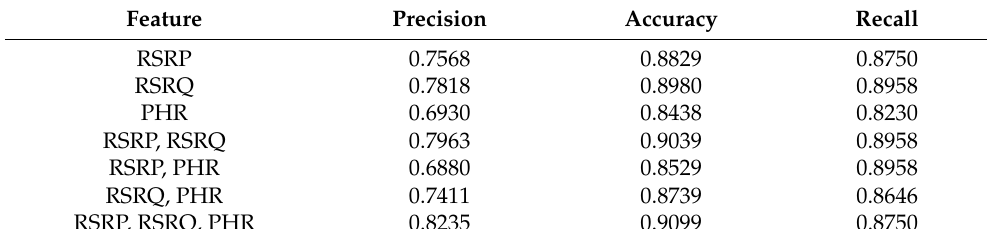
Table 2. Experimental results of different feature combinations.